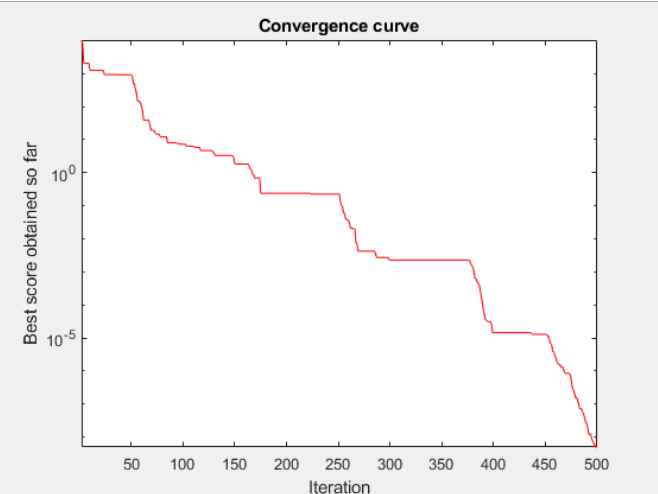
Figure 10. Iteration vs. best score obtained so far for predicting the severity using Ant Lion Optimization algorithm.